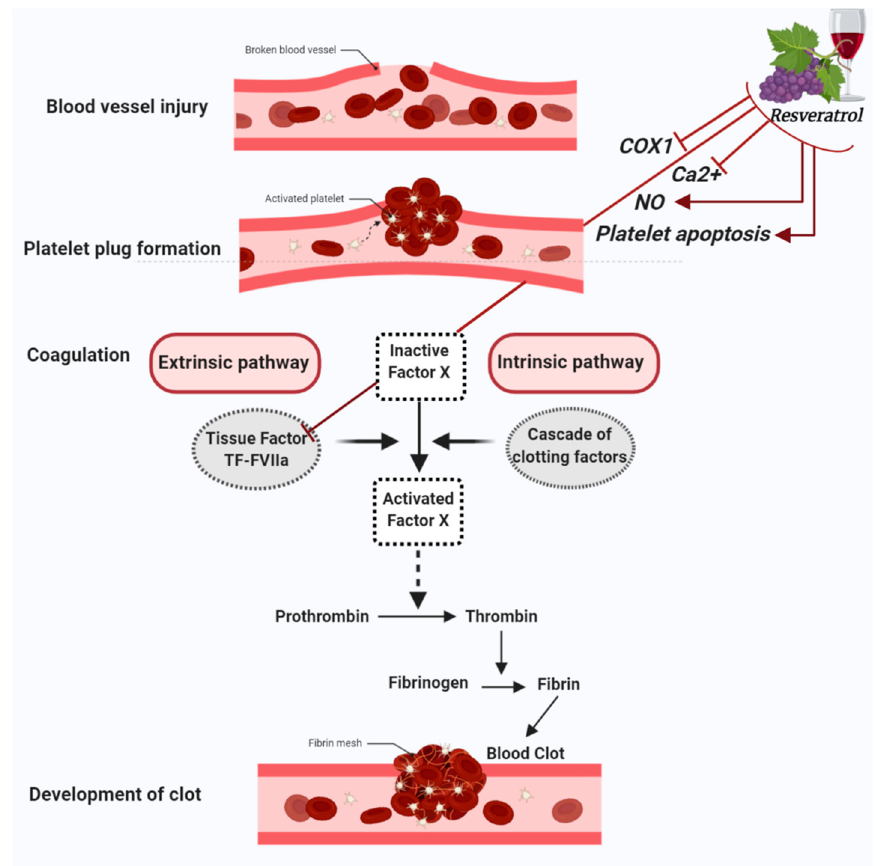
Figure 1. Figure summarizes the antiplatelet aggregation properties of resveratrol. Resveratrol inhibits cyclooxygenase-1 (COX-1), lowers nitric oxide (NO) concentration, decreases cytoplasmatic Ca 2+ and blocks Ca 2+ entry into platelets, which turn results in the suppression of platelet aggregation. Further antiplatelet aggregation properties of resveratrol are due to the activation of platelet apoptosis and the inhibition of Tissue factor (TF):FactorVIIa (FVIIa) complex (TF:FVIIa) formation.